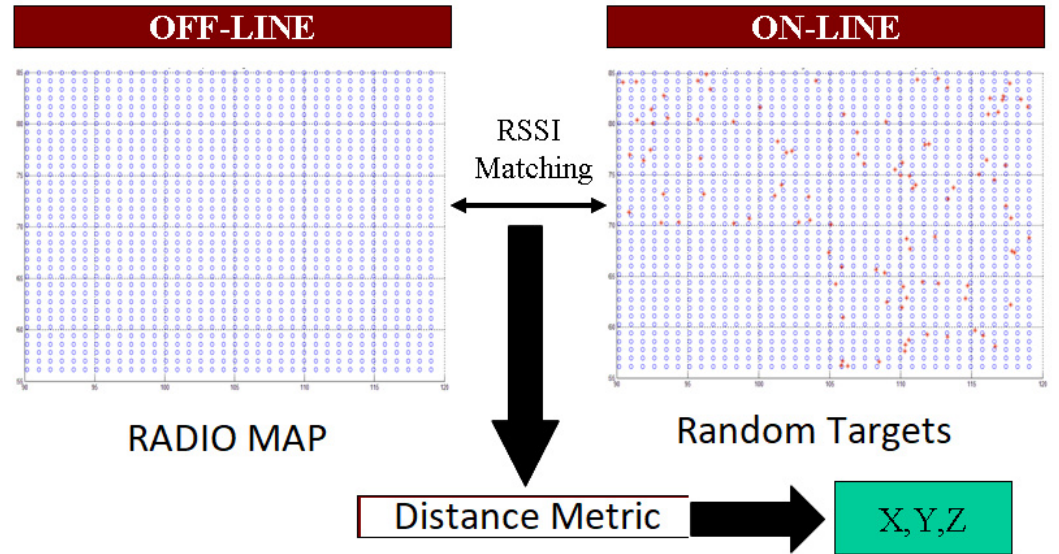
Figure 1. Fingerprinting technique: ( Left ) off-line phase; ( Right ) on-line phase.